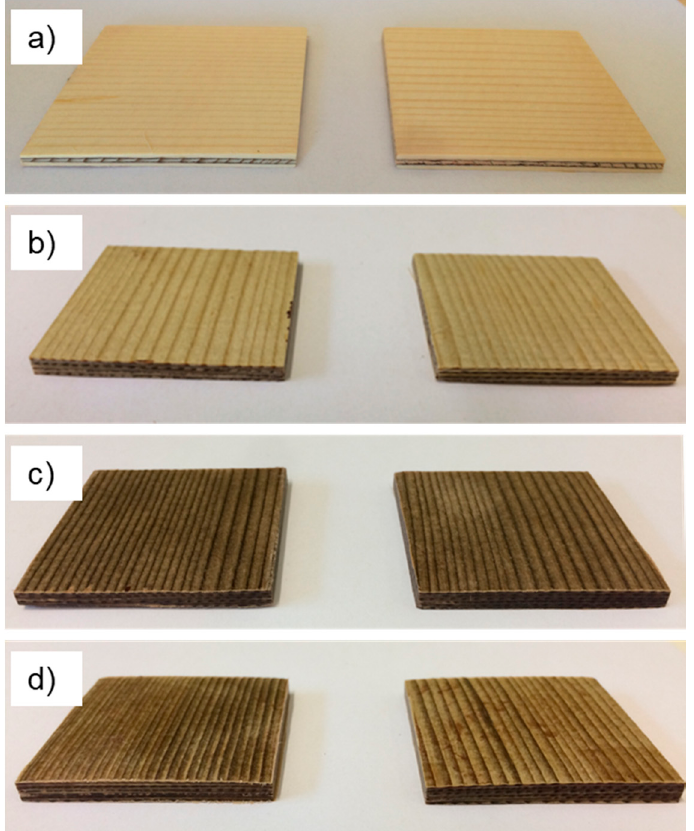
Figure 4. Representative photographs of plywood samples: ( a ) Made of reference veneers; ( b ) Made of densified water-soaked veneers; ( c ) Made of densified organosolv-treated veneers; ( d ) Made of densified alkali-treated veneers.